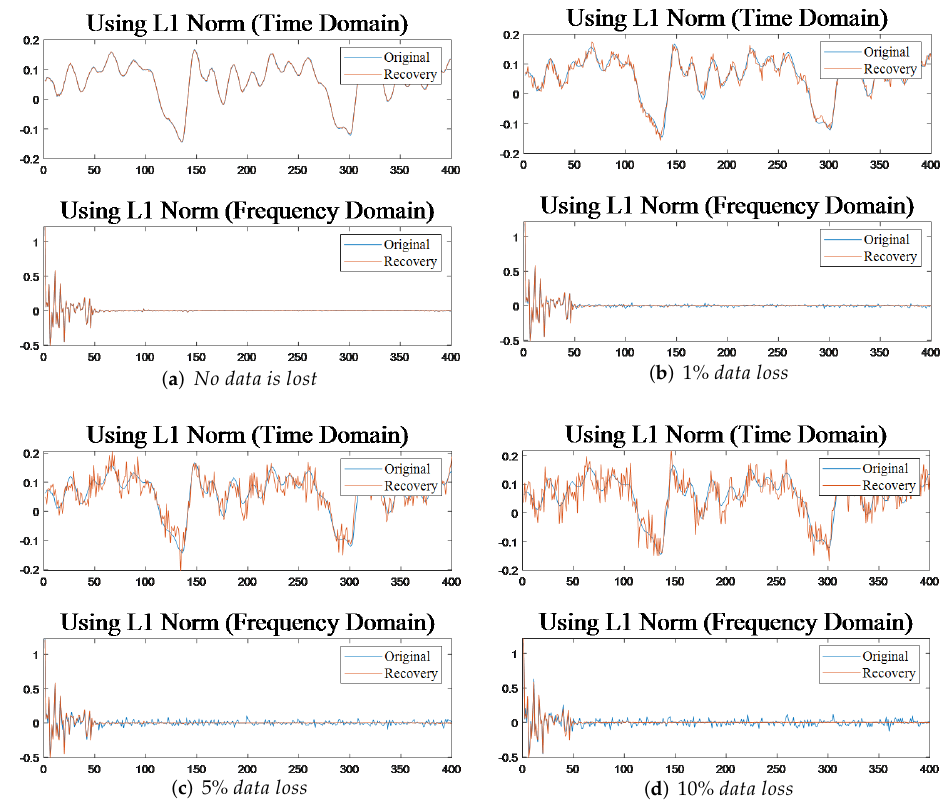
Figure 10. ( a ) m / n = 0.7, the time domain and frequency domain recovery of the encrypted sample without losing signal. ( b ) m / n = 0.7, the time domain and frequency domain recovery of the signal when the encrypted sample loses 1%. ( c ) m / n = 0.7, the time domain and frequency domain recovery of the signal when the encrypted sample is lost 3%. ( d ) m / n = 0.7, the time domain and frequency domain recovery of the signal when 5% of the encrypted sample is